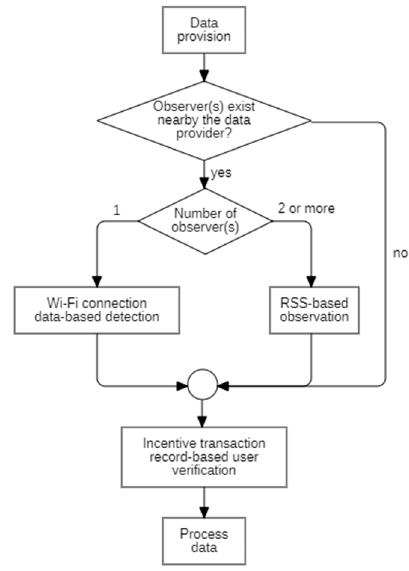
Figure 5. Sybil attack detection mechanism selection.